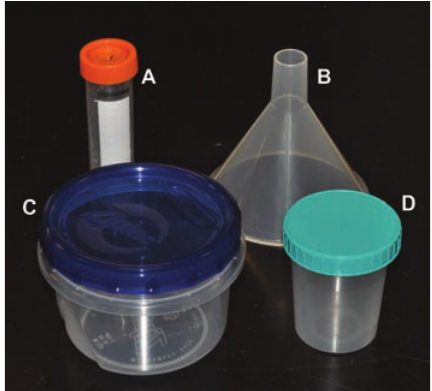
Figure 1: Materials used to construct the cage system. (A) Polypropylene 50 mL centrifuge tube with screwed cover, (B) polypropylene 250 mL lab funnel, (C) polypropylene Ziploc storage containers, and (D) high density polyethylene 120 mL specimen